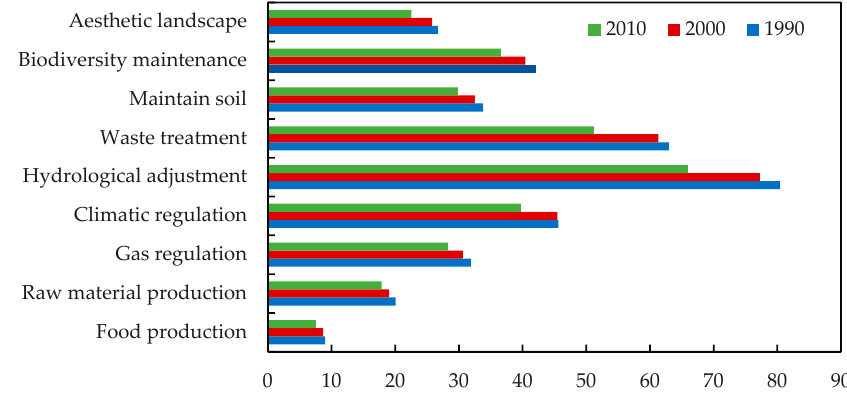
Figure 6. Individual ecosystem service function values (10 8 RMB) in the study area from 1990 to 2010. Table 6. Changes of structures of ESVs in the coastal zone in Zhejiang Province from 1990 to 2010.